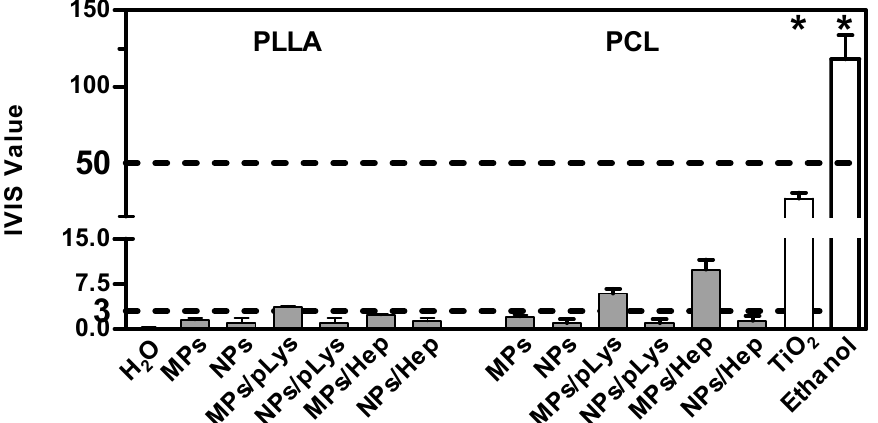
Figure 6. Eye irritation potential of polyester particles at the concentration of 0.5% by BCOP assay. Mean ± SD, n = 3. * p ≤ 0.05, ANOVA with post hoc Bonferroni